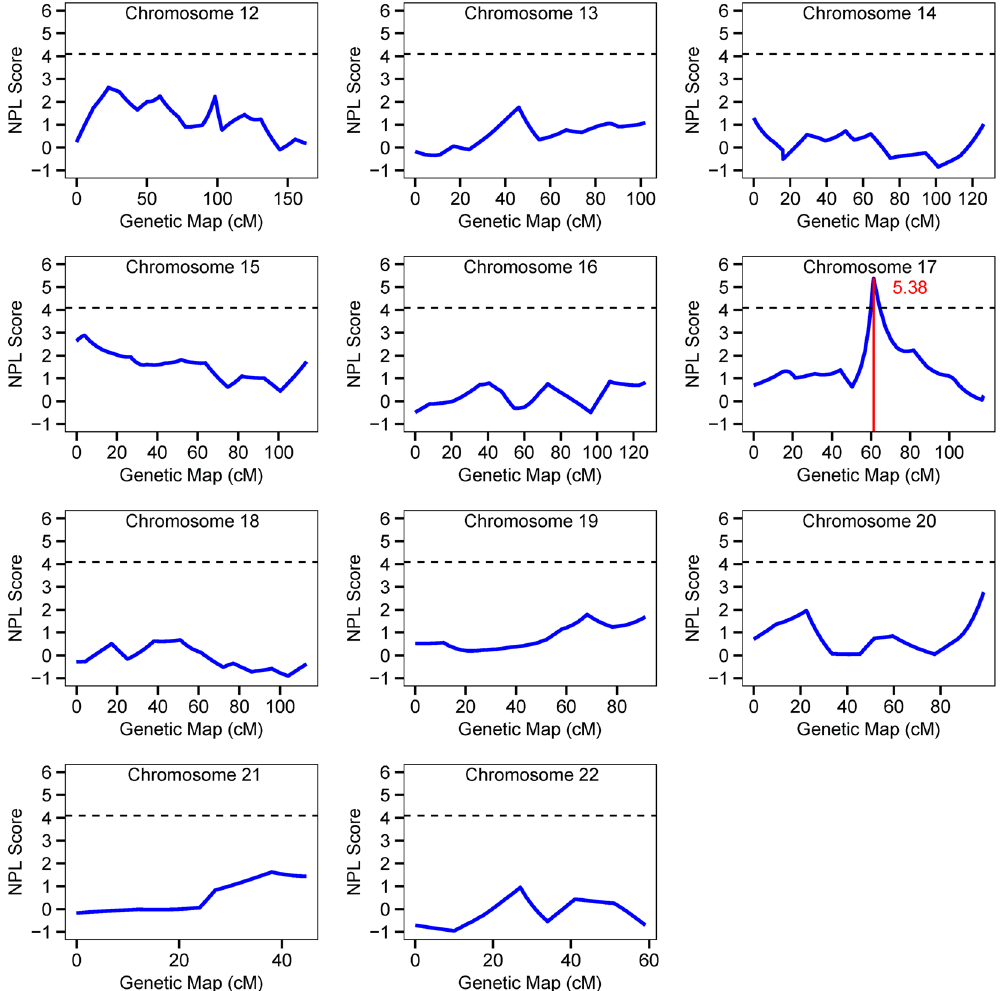
Figure 3. Genome-Wide Linkage Scan of Chromosomes 12–22 for CAD in 24 Large GeneQuest II families. X-axis and Y-axis indicate the genetic map of each chromosome and NPL scores from multipoint linkage analysis as shown by blue solid line, respectively. The red vertical solid line shows a significant linkage peak identified by two-point NPL analysis. The horizontal dash line represents the threshold of significant linkage with a multipoint NPL value of ≥ 4.08.